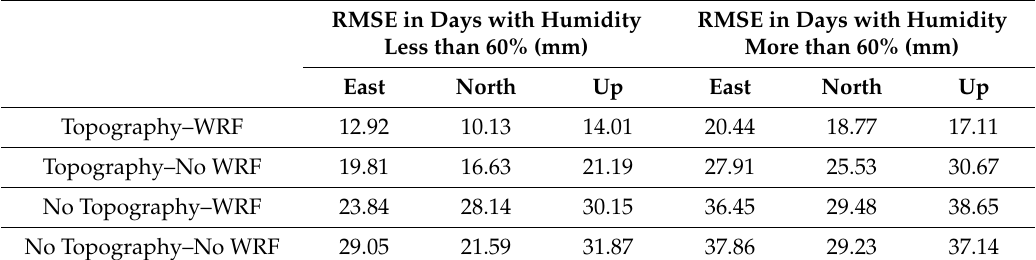
Figure 14. Positioning RMSE in different weather conditions. Table 3. Comparison of the obtained RMSE.